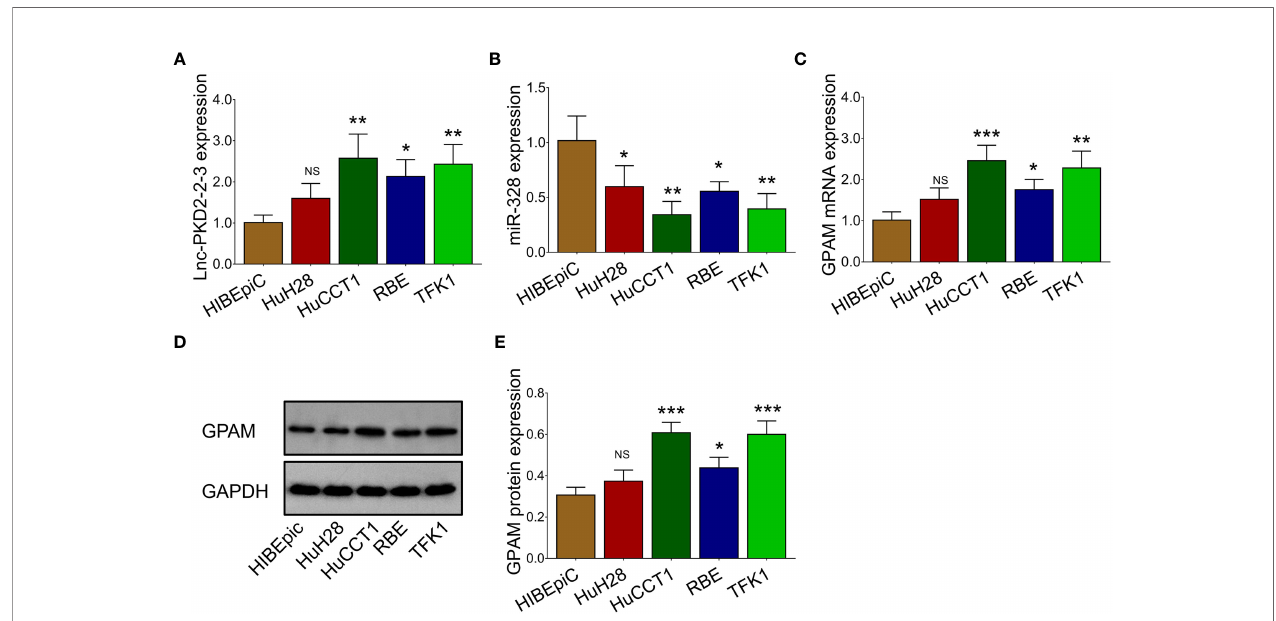
FIGURE 2 | Measurement of lnc-PKD2-2-3, miR-328 and GPAM in CCA cell lines. Comparison of lnc-PKD2-2-3 (A) , miR-328 (B) , and GPAM (C – E) between CCA cell lines and control cell line. NS, not signi fi cant; * P < 0.05; **, P < 0.01; *** P <